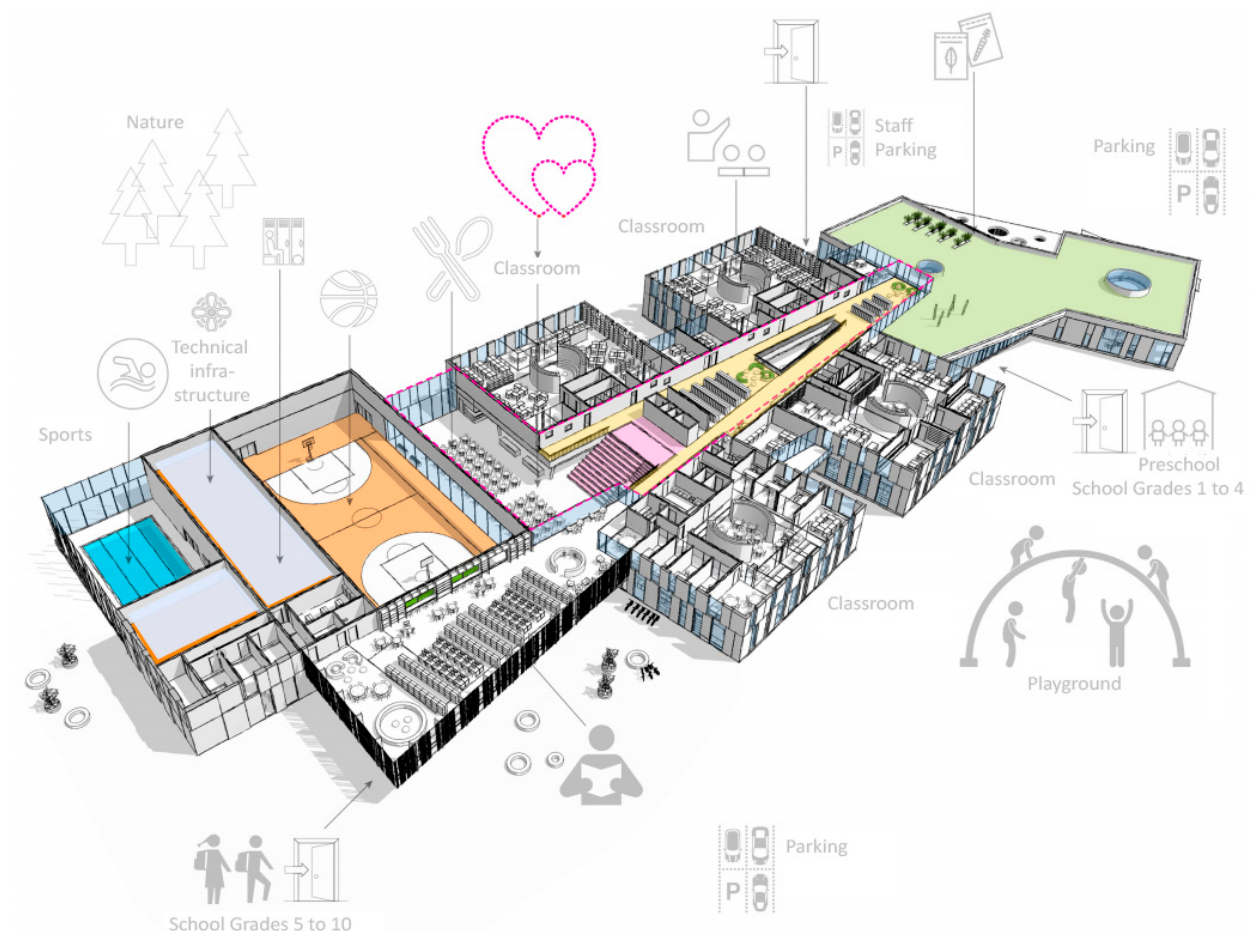
Figure 3. An early illustration of Stapaskoli from ARKÍS architects [30]. Sports facilities on the western end of the building complex, as well the preschool extension on the eastern end, have yet to be built. Two upper-floor classroom sections can be seen on the northern side. The library, a section for administrative functions, and a classroom section for art and crafts face the south. Three additional classrooms, a multifunctional hall, and music facilities lie hidden and out of sight on the lower floor.